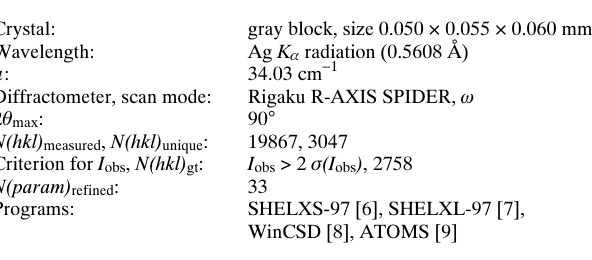
Table 5. Data collection and handling.